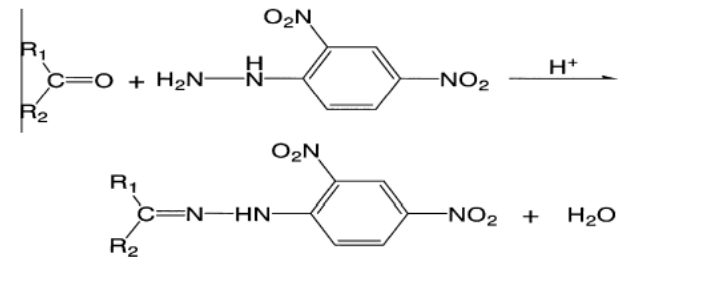
Table 4. Parameters of high-performance liquid chromatography instrument. Model